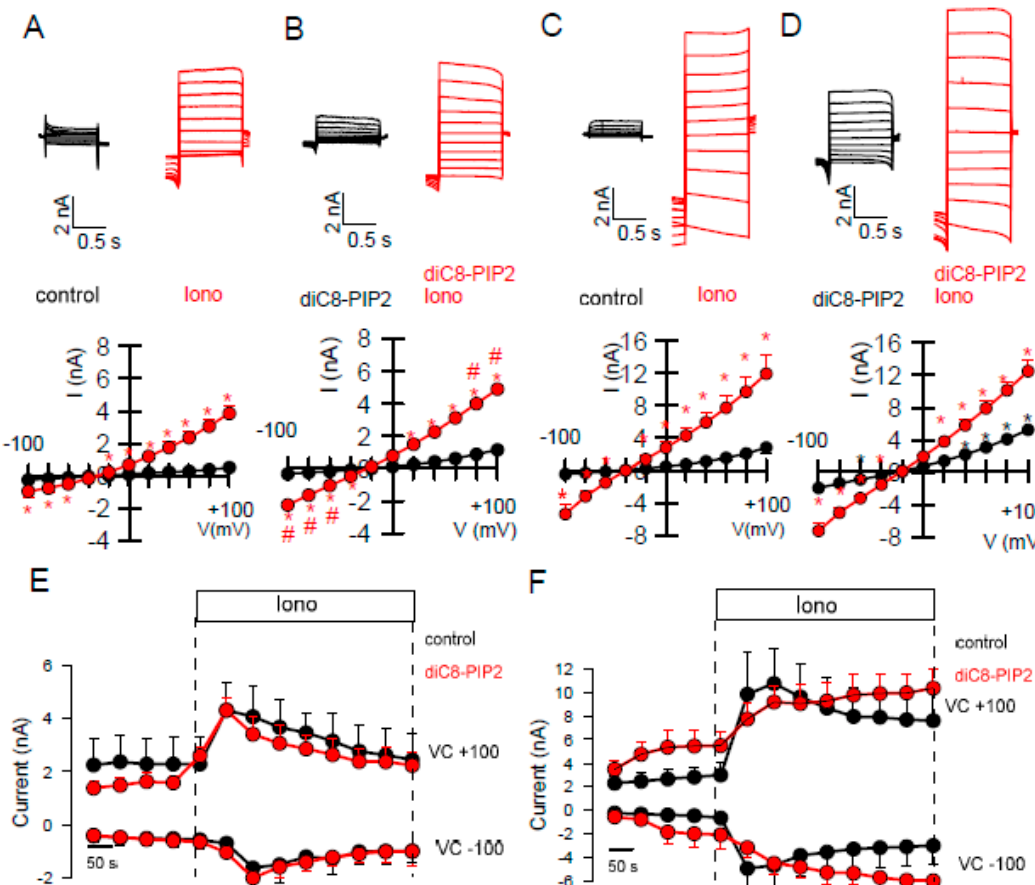
Figure 6. diC8-PIP2 augments TMEM16A currents activated by ionomycin. ( A – D ) Whole cell currents and I/V curves showing effect of diC8-PIP 2 (50 µM in the patch pipette filling solution) on basal and ionomycin (Iono, 0.1 µM) activated TMEM16A currents in HT 29 cells ( A , B ) and HEK293 cells ( C , D ). Activation of TMEM16A by diC8-PIP2 is clearly observed in TMEM16A-overexpressing HEK293 cells but not in HT 29 cells ( n = 6–7 for all). ( E , F ) Time courses for Iono-activated TMEM16A currents in HT 29 and HEK293 cells ( n = 6–8). * significant activation ( p < 0.05; paired t -test). # significant difference to the absence of diC8-PIP 2 ( p < 0.05; unpaired t -test).